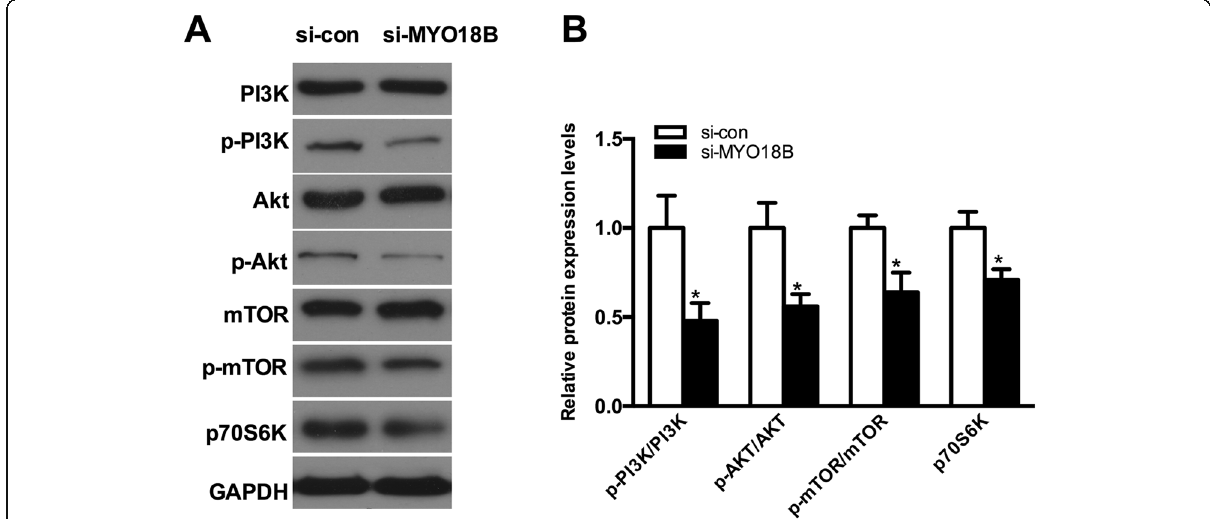
Fig. 4 The effect of MYO18B on PI3K/AKT pathway. a Western blot assays were used to measure the expression of PI3K, p-PI3K, AKT, P-AKT, mTOR, p-mTOR and p-P70S6K proteins in the transfected HepG2 cells. b Quantification of PI3K, p-PI3K, AKT, P-AKT, mTOR, p-mTOR and p-P70S6K proteins was performed and normalized to the GAPDH a loading control. * P <0.05 versus si-con